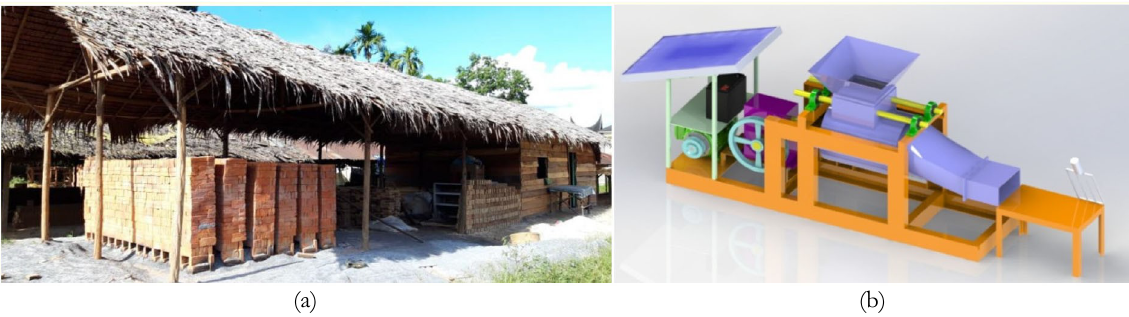
Figure 8. (a) clay bricks (b) the design of a solar power-machine